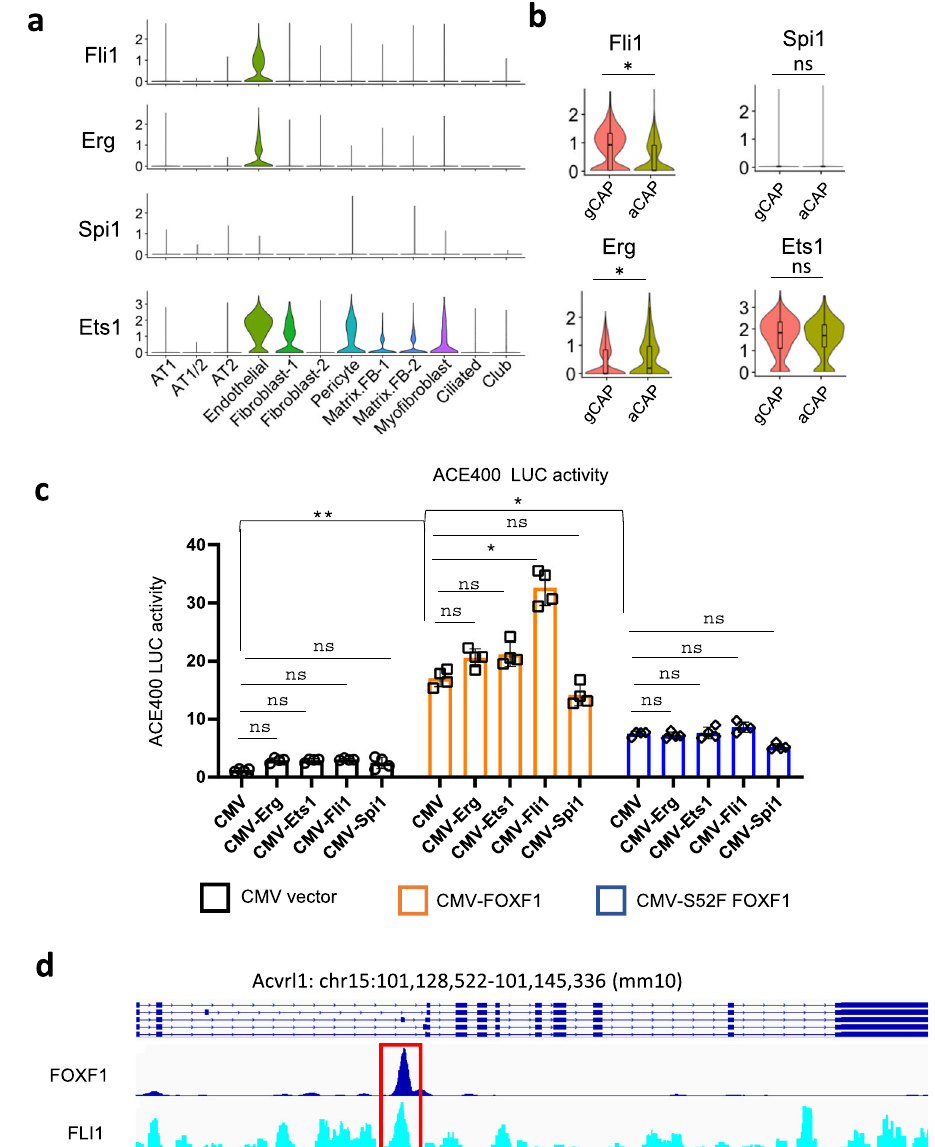
Fig. 6 FOXF1 synergizes with FLI1 to stimulate Acvrl1 promoter activity. a Violin plots were generated using a combined pool of cells from WT and Foxf1 WT/ S52F E18.5 lungs and show endothelial-enriched expression of ETS transcription factors Fli1 , Erg and Ets1 . ETS transcription factor Spi1 is not expressed in endothelial, epithelial, and mesenchymal cell lineages in the lung tissue. b Violin plots show that Fli1 is enriched in gCAPs, whereas Erg is enriched in aCAPs. Ets1 expression is similar in aCAPs and gCAPs. The data for box plots were from single cell normalized counts (WT: n = 532; Foxf1 WT/S52F : n = 320). Boxplots: center line, median; box boundary, fi rst and third quartiles; whiskers denote 5th – 95th percentile. T -test (two-tailed) were performed, pvalue for Fli1 is 0.01677, and for Erg is 0.02791. c Dual luciferase (LUC) assay shows transcriptional synergy between CMV-FOXF1 and CMV-FLI1 expression vectors to activate the ACE400 LUC reporter. Co-transfection experiments were performed using fetal lung MFLM-91U cells ( n = 4). Data were shown as mean±SD, and one-way ANOVA followed by Tukey ’ s test (two-tailed) were performed. ** p <0.01, * p <0.05, ns is not signi fi cant. d ChIPseq shows that FOXF1 and FLI1 proteins bind to the ACE400 region of Acvrl1 gene (red